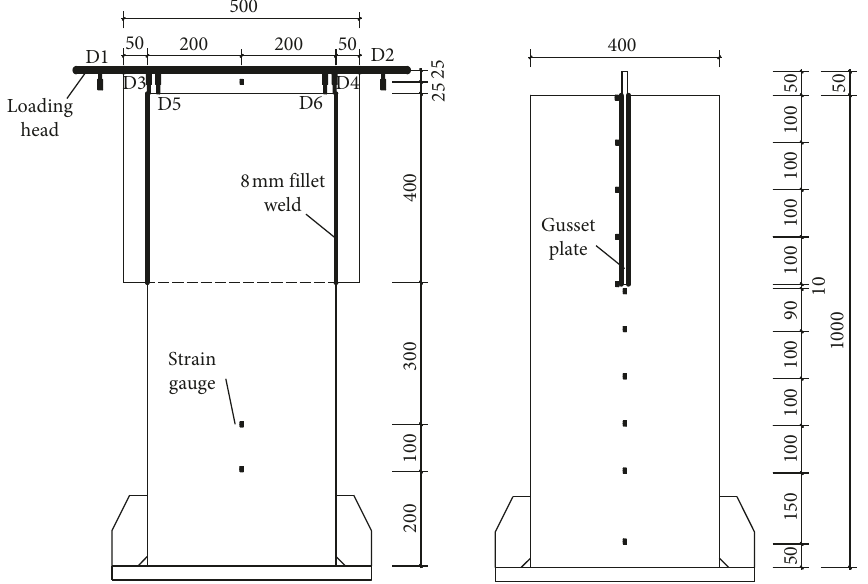
Figure 4: Dimensions of the specimen and location of strain